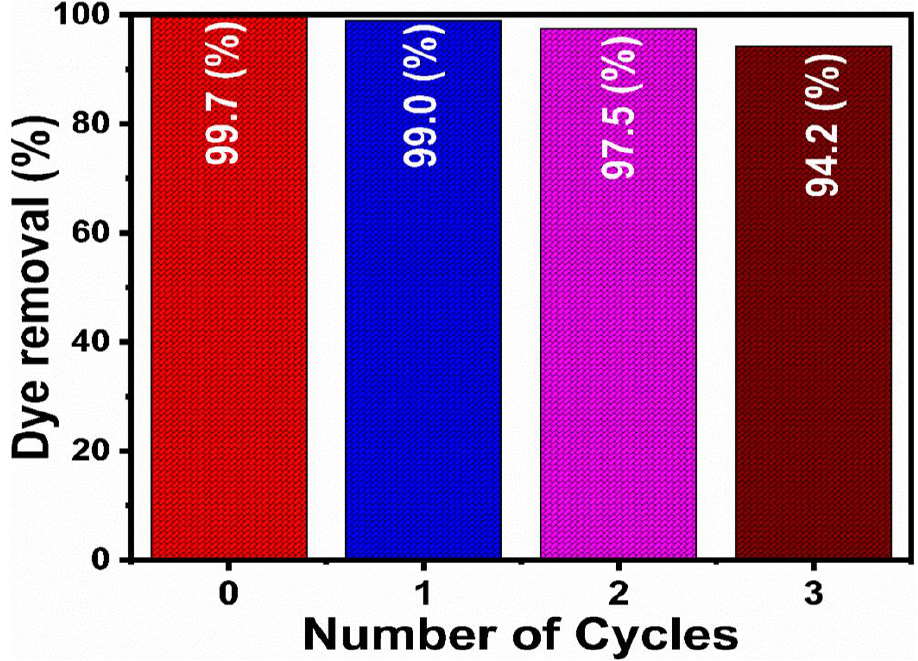
Figure 15. Reusability test of green synthesized ZnO (Sample-4) during the photodegradation of MB dye under the irradiation of natural sunlight irradiation.